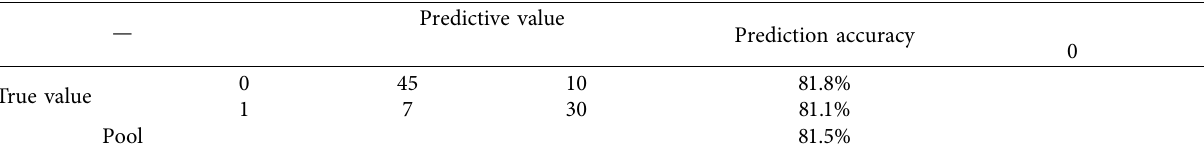
Table 3: Summary of prediction accuracy of binary Logit regression.